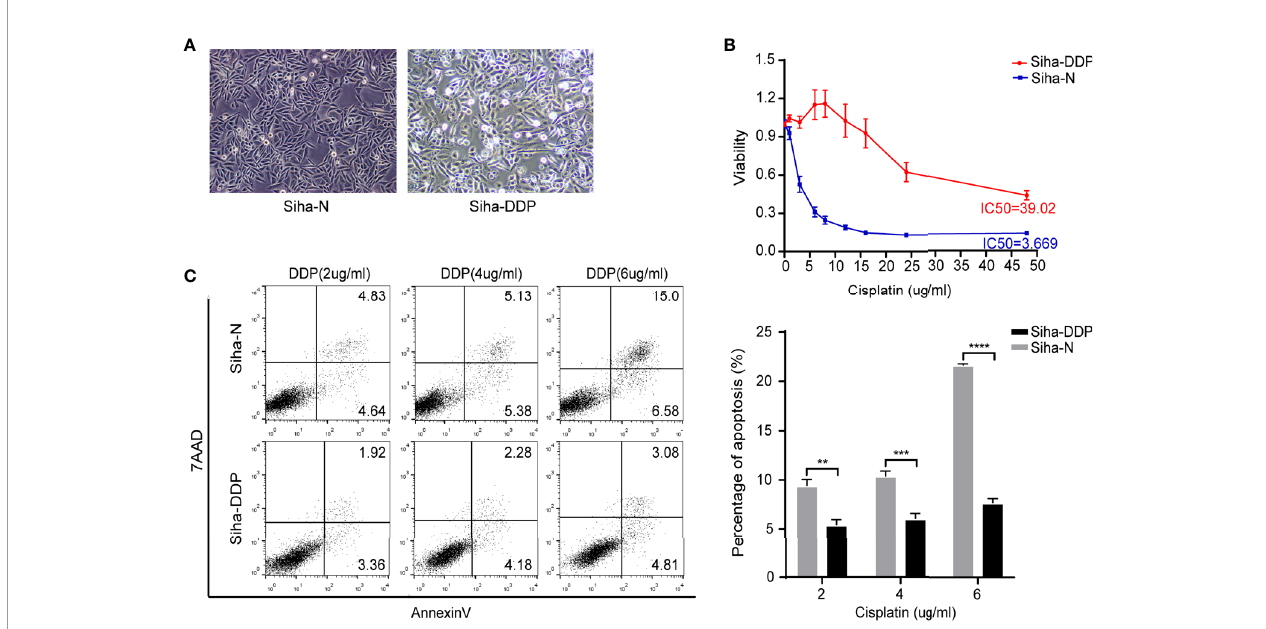
FIGURE 1 | Construction of cisplatin-resistant Siha cell line. (A) Morphology of Siha-N and Siha-DDP. (Magni fi cations, 200×). (B) Cell viability under the increasing concentration of cisplatin detected by CCK8 assay. IC50, 50% inhibiting concentration. The data are presented as mean ± SD. Error bars indicate SD. (C) Cell apoptosis rate under various concentrations of cisplatin. The apoptosis rate = early apoptosis rate + late apoptosis rate. The data are presented as means ± SD of three independent experiments. Error bars indicate SD (**P < 0.01, ***P < 0.001, ****P <